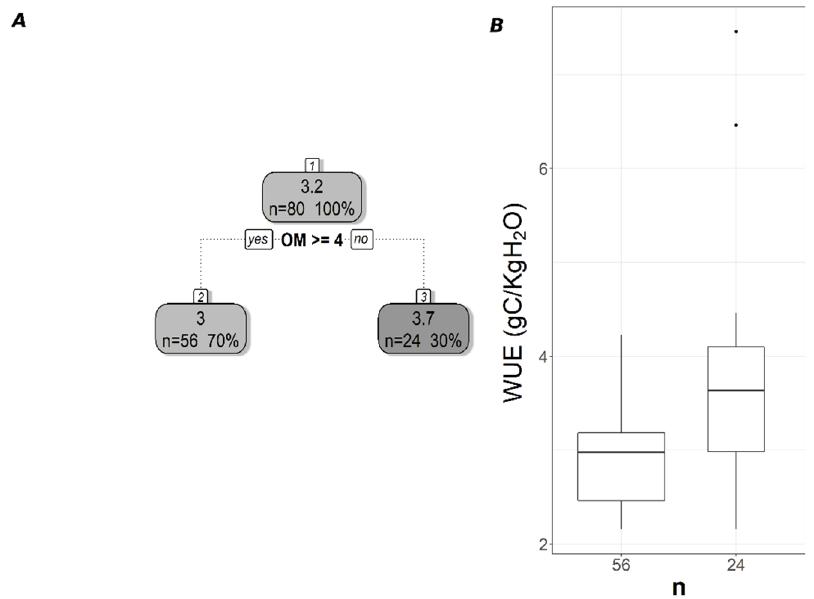
Figure 5. Pruned regression tree for ( A ) WUE SIF predicted as a function of one significant variable. The number in box 1 represents the mean WUE SIF of the node, n value represents the terminal node size, soil variables names under the boxes represent the splitting criterion, and the numbers in boxes 2 and 3 represent the mean estimated CUE. Note that the position of “yes” and “no” at each split represents the decision split at each node. ( B ) Boxplots showing the distribution of WUE in each terminal branch in the regression tree. The model has r 2 of 0.19 and MAE of 0.64 gC/KgH 2 O for WUE.